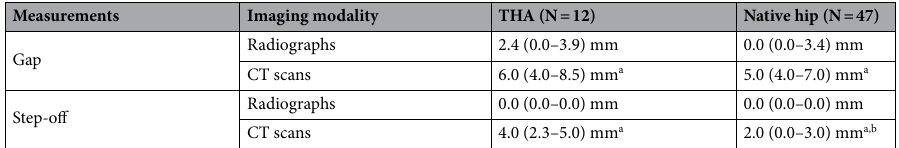
Table 3. Differences in median (interquartile range) postoperative gap and step-off on radiographs and CT scans between patients with a total hip arthroplasty (THA) and those who retained their native hip at follow-up. a Significant difference between measurements on radiographs and CT scans, with a P-value < 0.05. b Significant difference in the median step-off on CT scans, between patients with a THA and those who retained their native hip at follow-up.